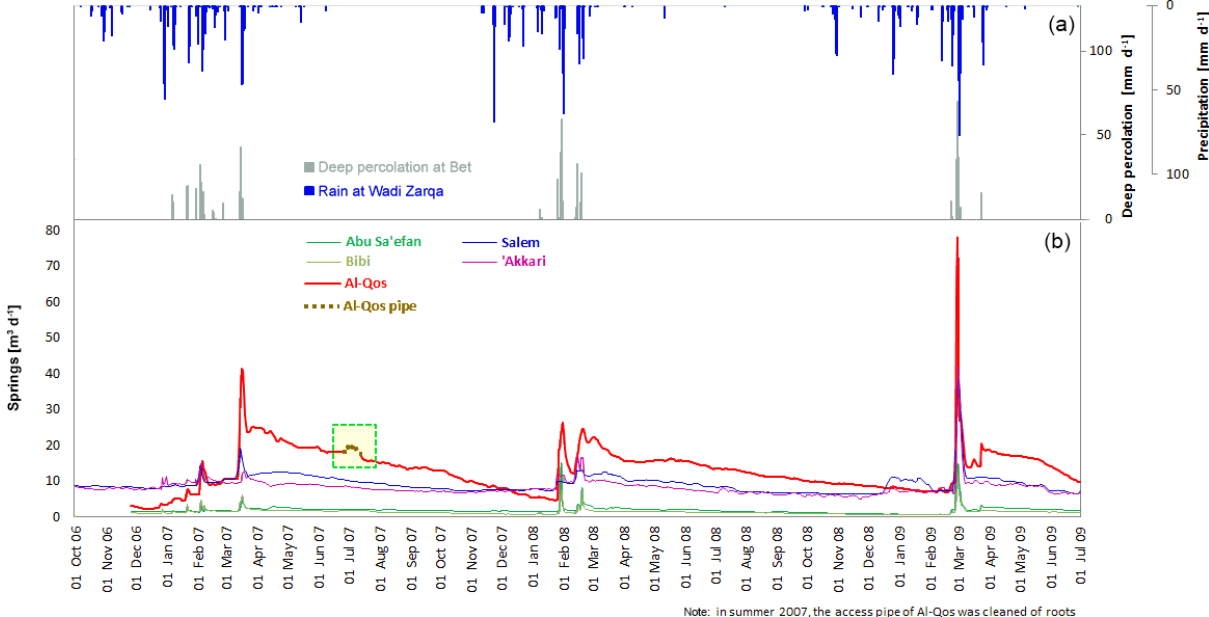
Figure 7. Signatures of peak spring flow and DP events. Yellow-shaded box: temporary increase in spring discharge caused by the cleaning of plant roots from the access pipe at the Al-Qos spring (July 2007). Daily measured spring flow at the Beitillu spring group is shown in red, olive and green (b) . At the Wadi Zarqa group in blue and purple, daily deep percolation is shown as grey columns (upper half), and precipitation is shown as blue columns (a) . Table 2. Annual precipitation and recharge rates (DP) modelled at representative SM locations.